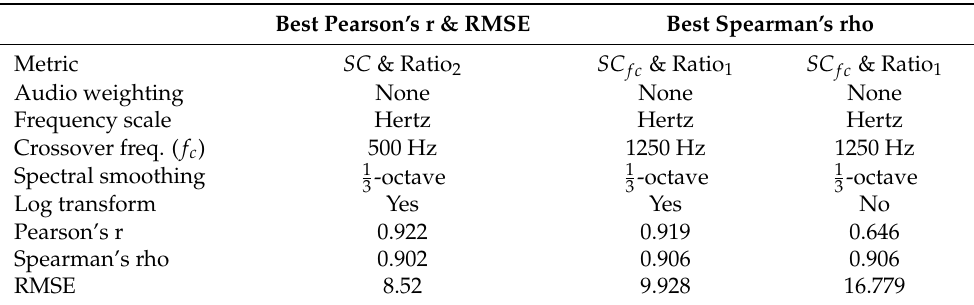
Table 2. Best-performing (lowest root mean square error (RMSE), highest Pearson’s r, highest Spearman’s rho) metrics from the original 8484 candidates. Best Pearson’s r & RMSE Best Spearman’s